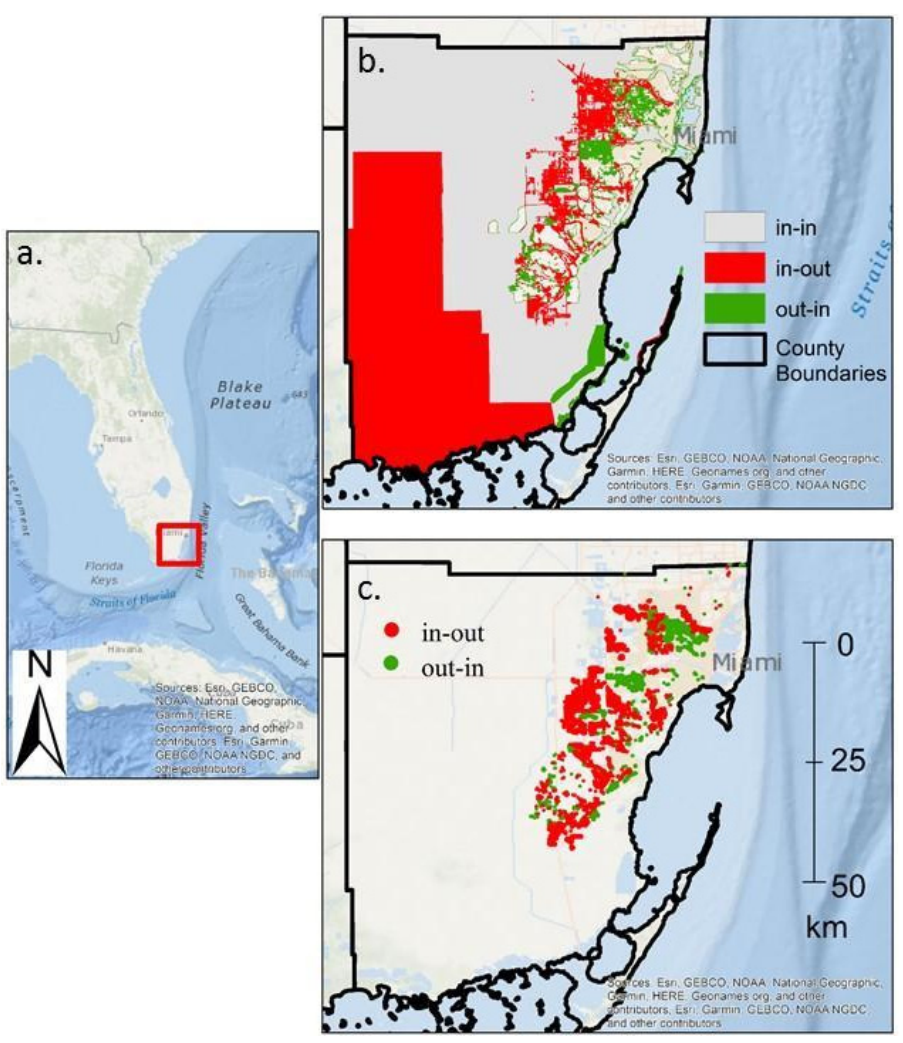
Figure 1. ( a ) The study area for this research, which is located within the southeastern portion of the state of Florida, ( b ) SFHA status for areas within Miami-Dade County for the 1994 and 2009 FEMA FIRM maps (1994–2009), and ( c ) the centroids of properties that experienced a change in SFHA zone designation from the 1994 to the 2009